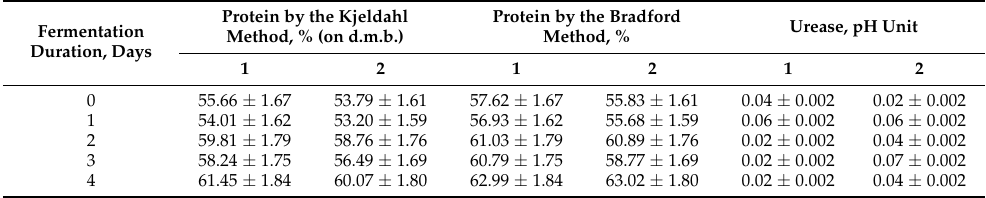
Table 1. Results of quantitative determination of the content of crude protein and urease activity in samples at different fermentation duration. Protein by the Kjeldahl Fermentation Method, % (on Duration, Days